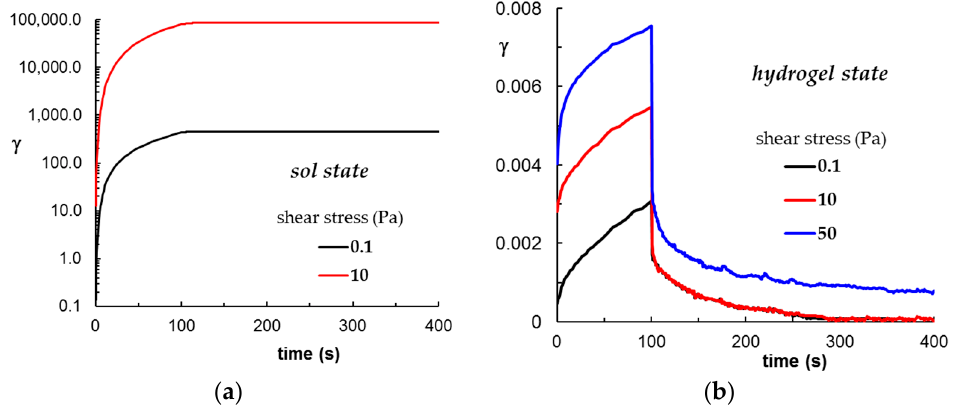
Figure 4. The deformation during creep and recovery for PVA/HPC mixture ( a ) in solution state and ( b ) physical hydrogel obtained by freezing/thawing.